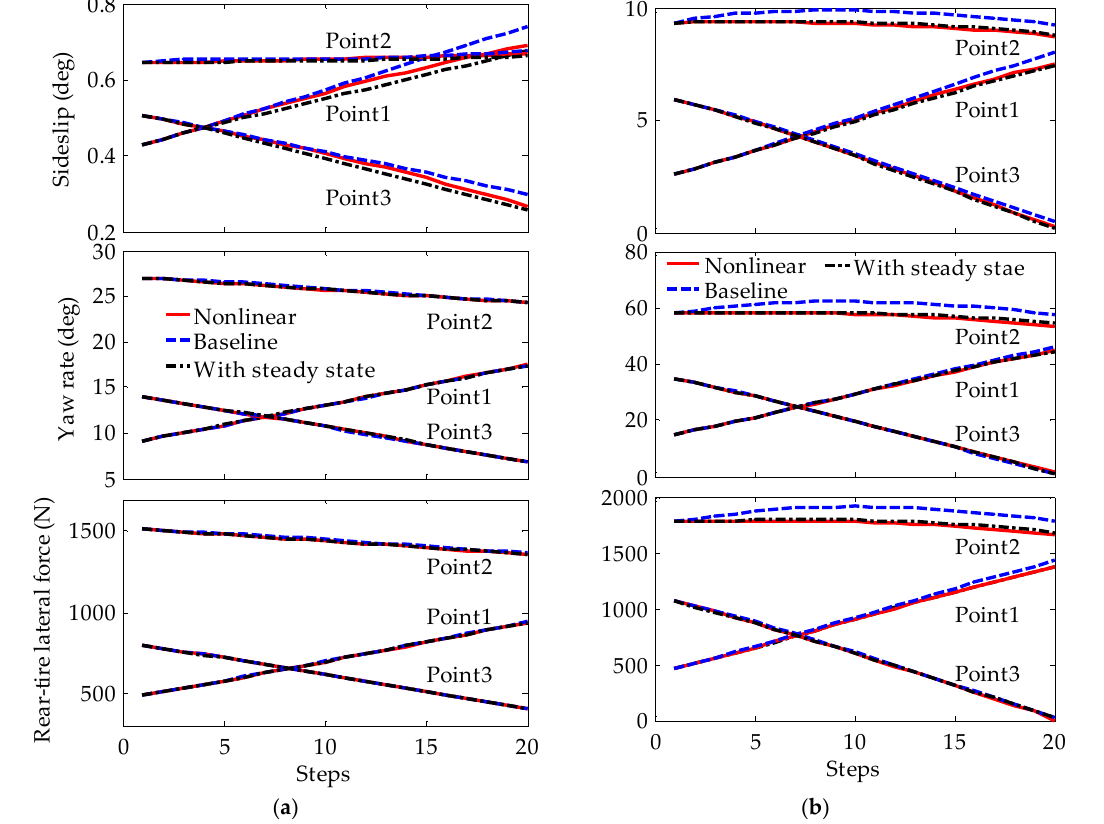
Figure 8. The prediction results of different linearization models in ( a ) R = 30 m, U x = 45 km/h and ( b ) R = 8 m, U x = 25 km/h cases.